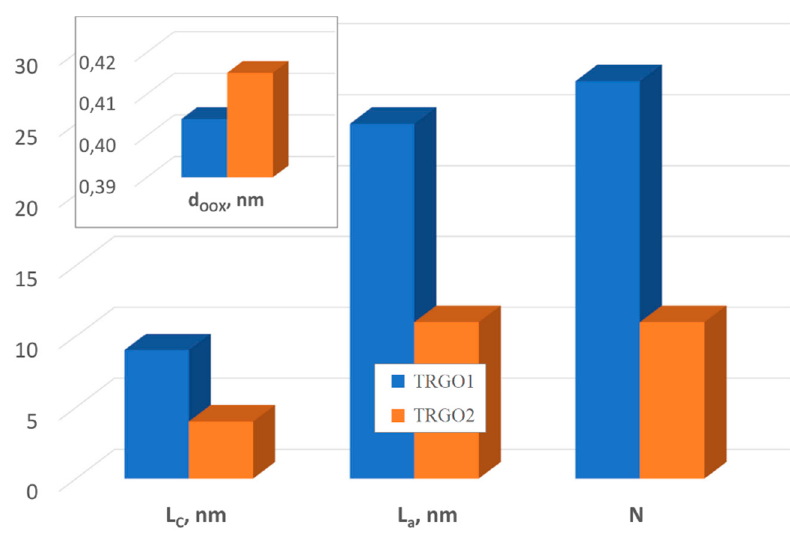
Figure 6. The structural parameters determined using XRD method.